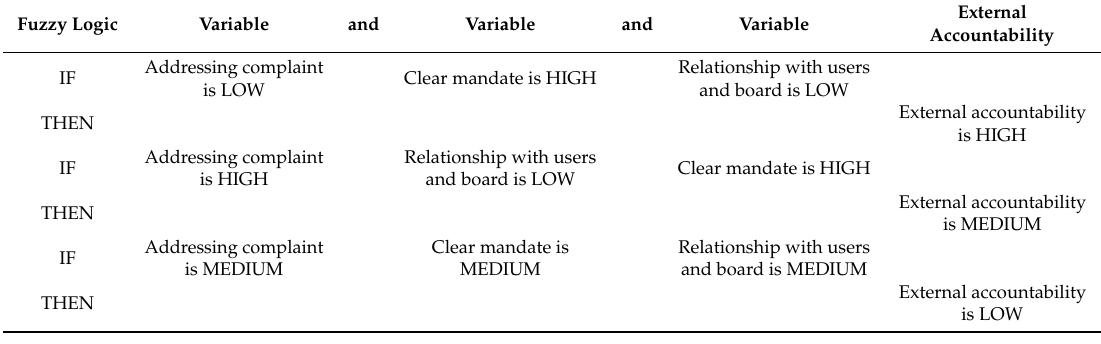
Table 3. Risk inference for external accountability.